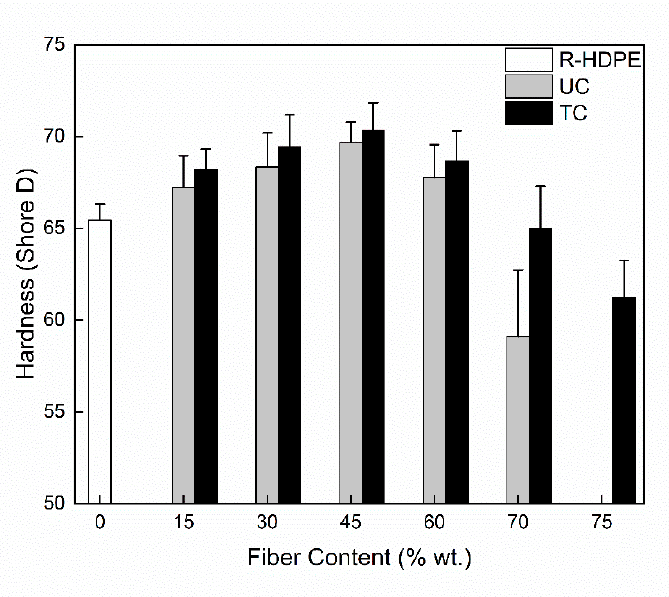
Figure 10. Hardness (Shore D) of the recycled high-density polyethylene (R-HDPE), untreated (UC) and treated (TC) composites as a function of fiber